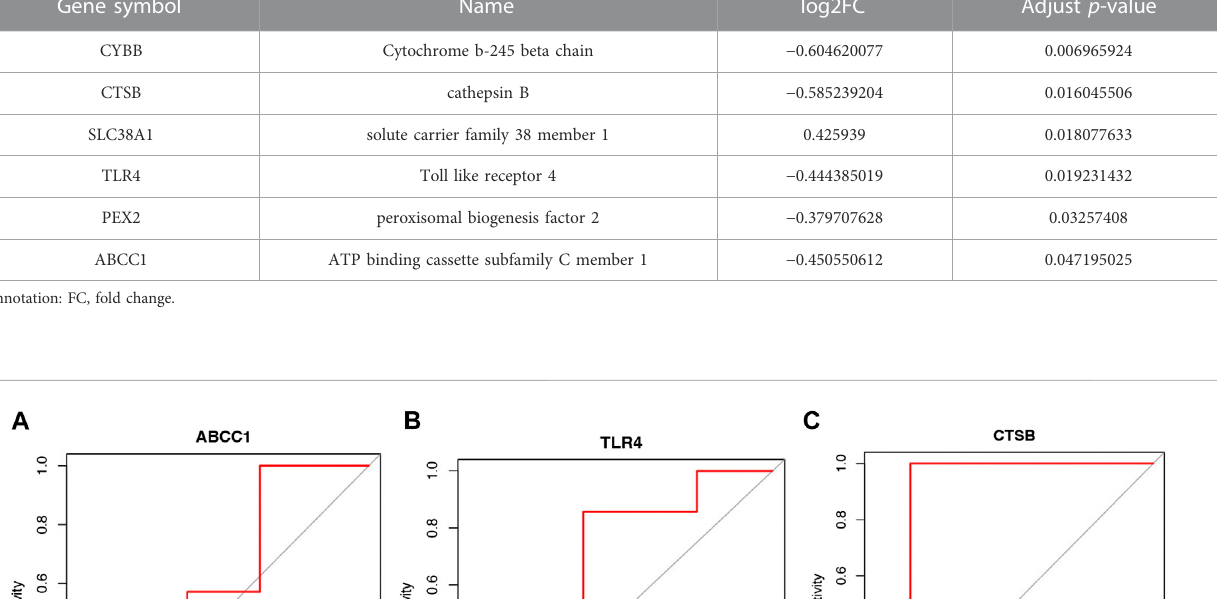
The ROC curve of six FRGs based on GSE58331 is presented in Figure 2C.